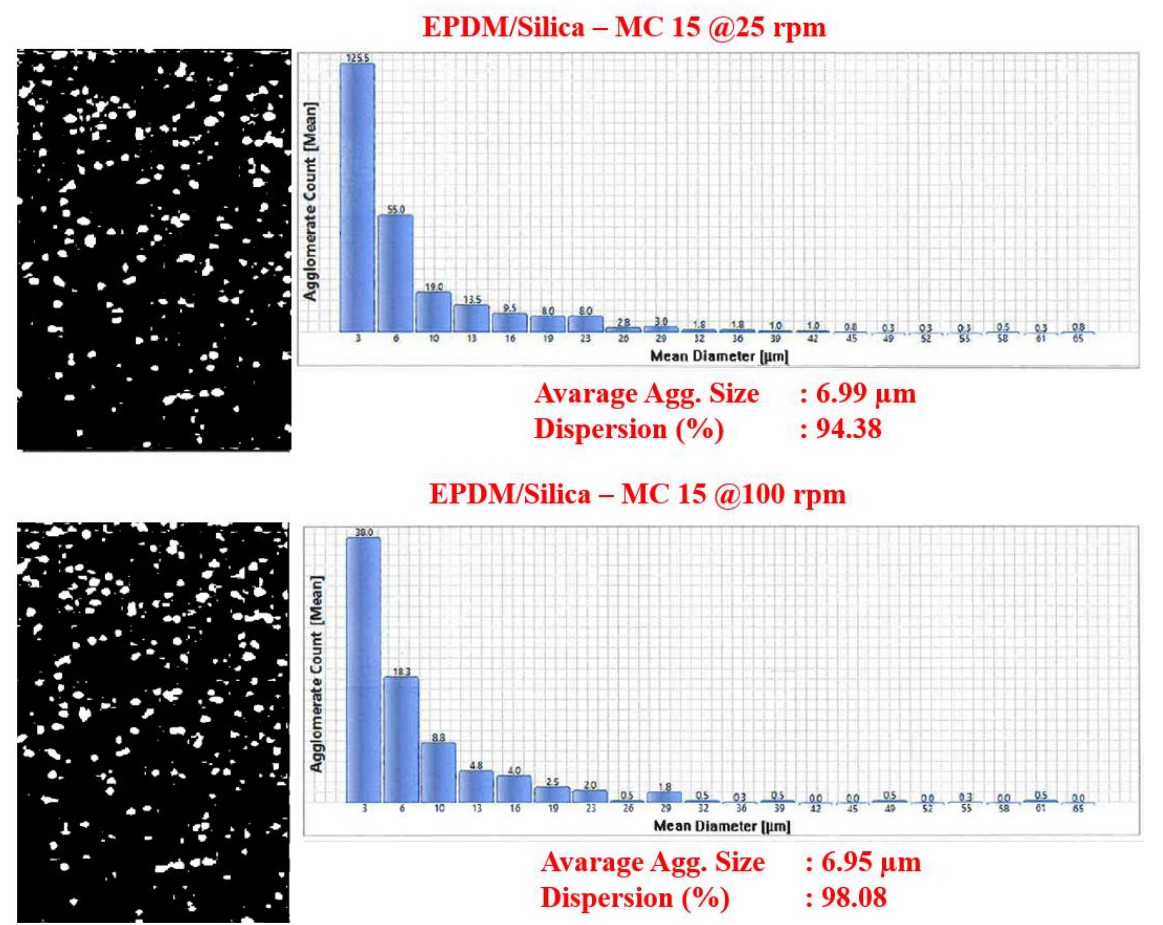
Figure 7. Silica dispersion in EPDM composites prepared in MC 15 HT.